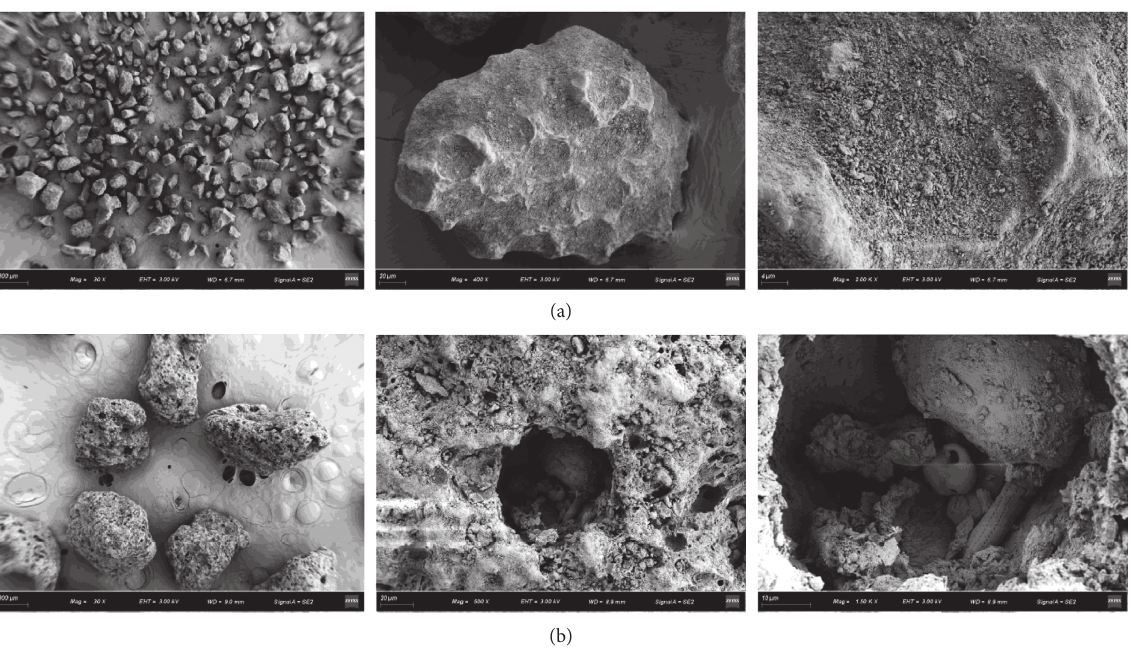
Figure 2: SEM images of calcareous sands. (a) Calcareous sand from dredger fill site. (b) Natural calcareous